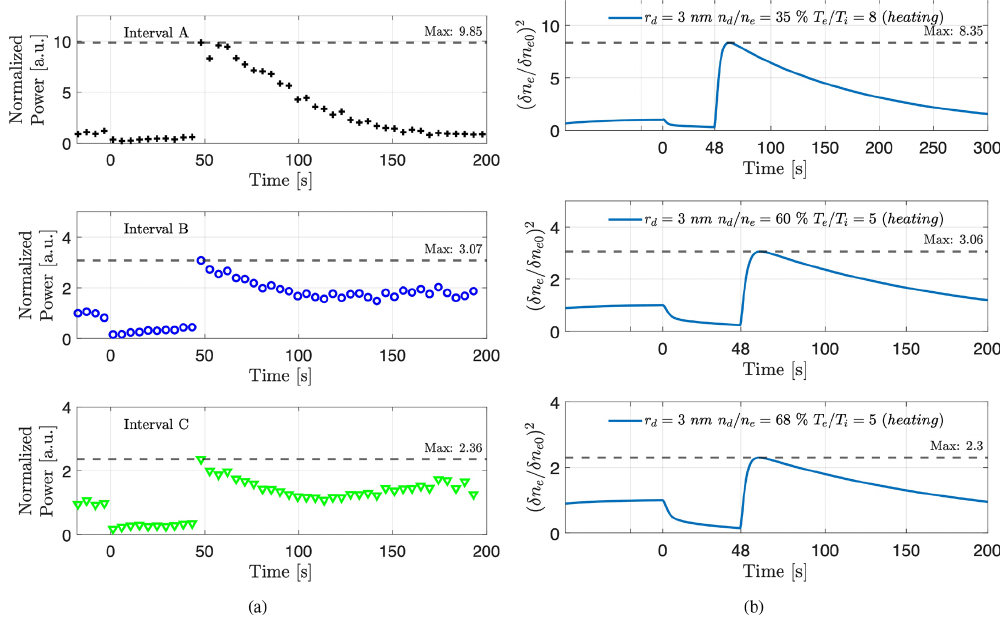
Figure 17. Comparison of the averaged and normalized heating cycles for each interval (a) to its corresponding simulation of the overshoot cycles (b) . Note the longer timescale of simulation of interval A (longer time needed for simulation to return to